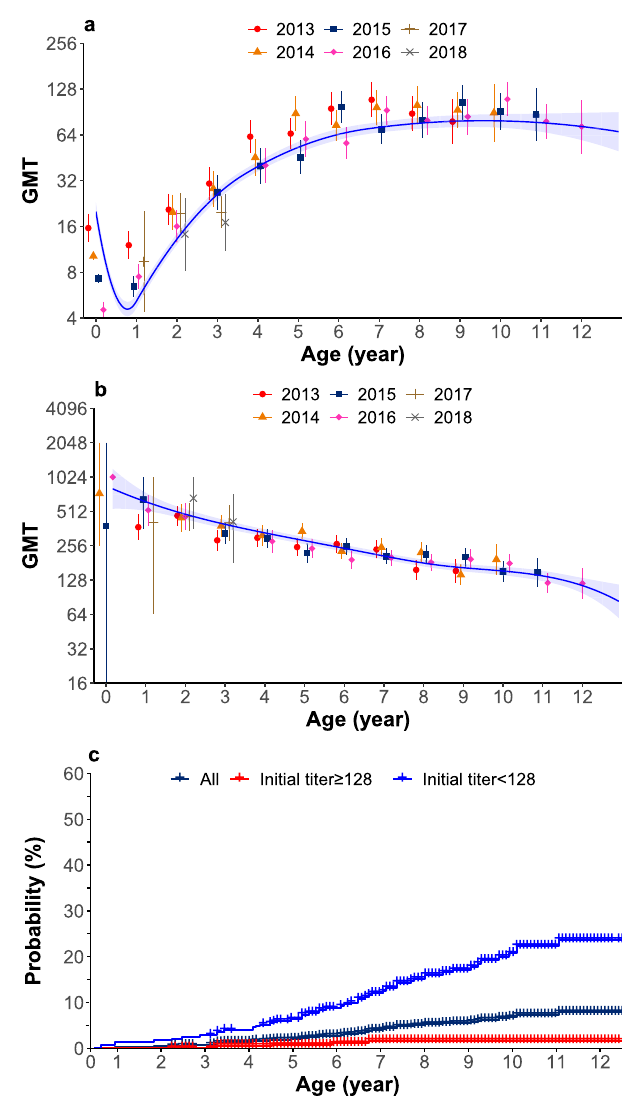
Fig. 3 | EV-A71 geometric mean titres (GMT) with age and probability of returningtobesusceptibletoEV-A71.a GMTforallstudyparticipantsinChildren and Neonates cohort. Dots and line represent observed and predicted GMT, respectively; error bars and shadow represent 95% CI. b GMT in the seropositive participants, excluding maternal antibody titres. Dots and line represent observed and predicted GMT, respectively; error bars and shadow represent 95% CI. c Kaplan – Meierplotoftheprobabilityoflossofimmunityinparticipantswhowere infected. Note: the sample size of panel a and panel b was listed in Supplementary Table